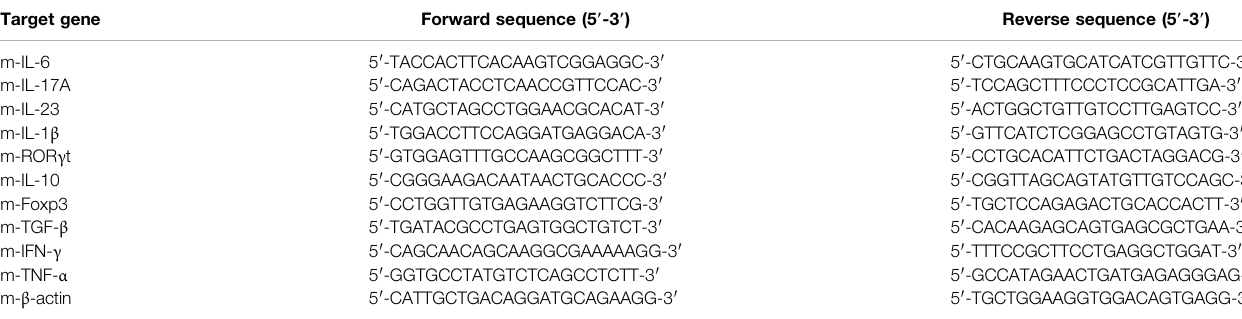
TABLE 1 | Primers used for the real-time